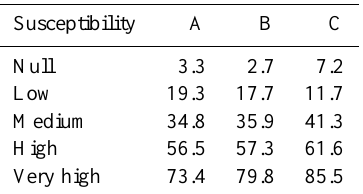
Table 4. Observed landslide frequency (%) in true positive land units of the best susceptibility maps obtained: (A) with square cells and grouped variables; (B) with square cells and dummy variables; (C) with slope units and dummy